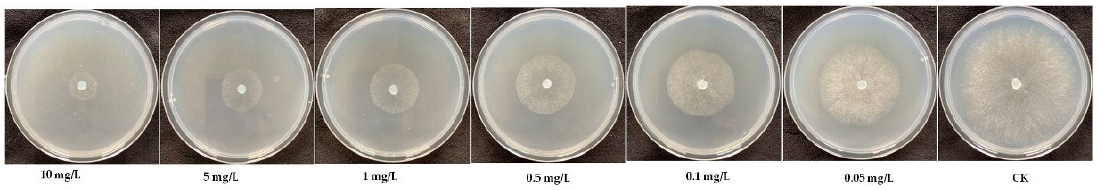
Figure 1. Effects of different concentrations of penthiopyrad on mycelial growth of Botrytis cinerea isolate 15SJG5 collected in 2015 from tomato plants affected by gray mold cropped in Shijiazhuang. CK indicates the fungus grown on the PDA plate was a